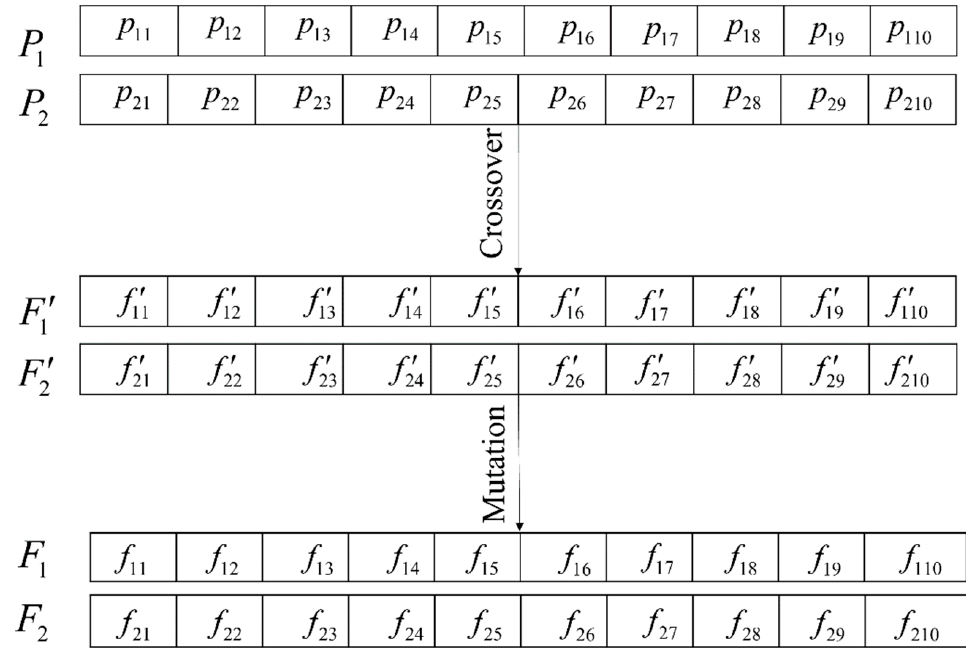
Figure 2. Generating new offspring using the genetic algorithm.